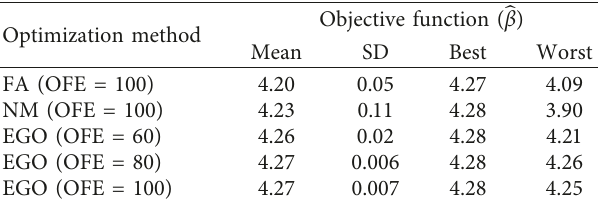
Table 3: 2-FTMD system (Case 2): results for different optimi- zation methods over 10 independent